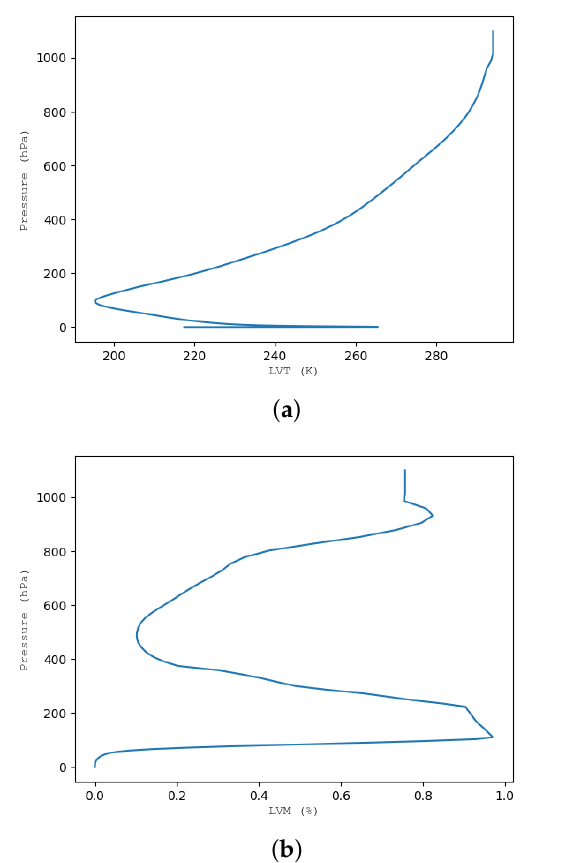
Figure 9. Vertical data distribution of LVT ( a ) and LVM ( b ) over atmospheric